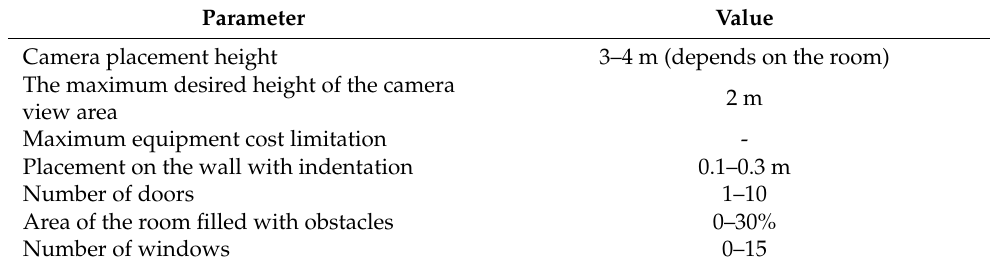
Table 5. Premises parameters in experiments.